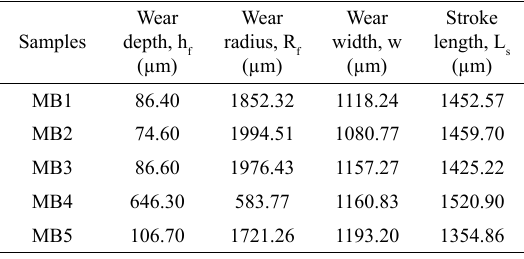
Table 6. Wear scar measurement and variables